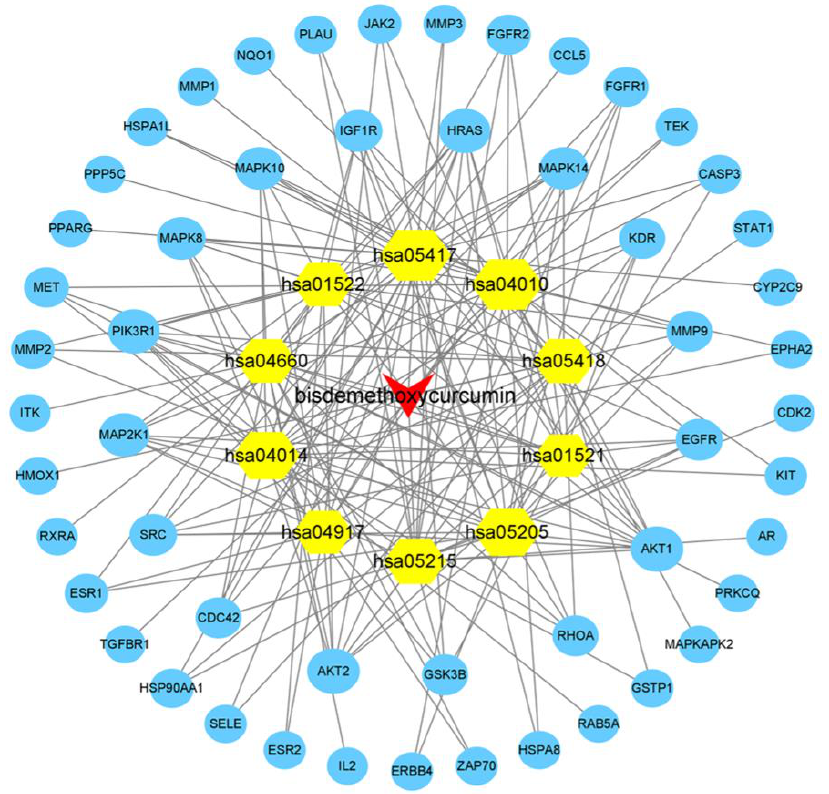
Figure 4. The construction BDMC-target-pathway network. The red inverted triangles represent BDMC, the blue ellipses represent target genes, and the yellow hexagons represent the top 10 KEGG pathways of BDMC treating UC. The gray lines represent their